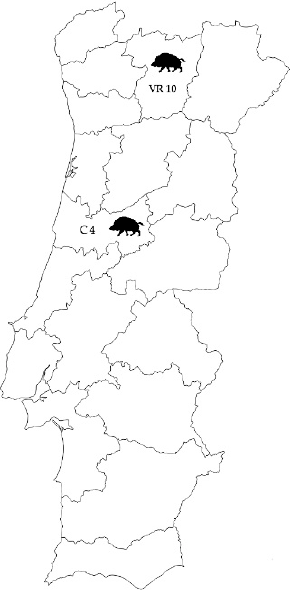
Figure 1. Illustration of the geographical origin of the samples collected in Portugal and evaluated in this study. Samples were collected from 10 wild boars during a national campaign in Vila Real (VR10) and 4 wild boars during a national campaign in Coimbra (C4).